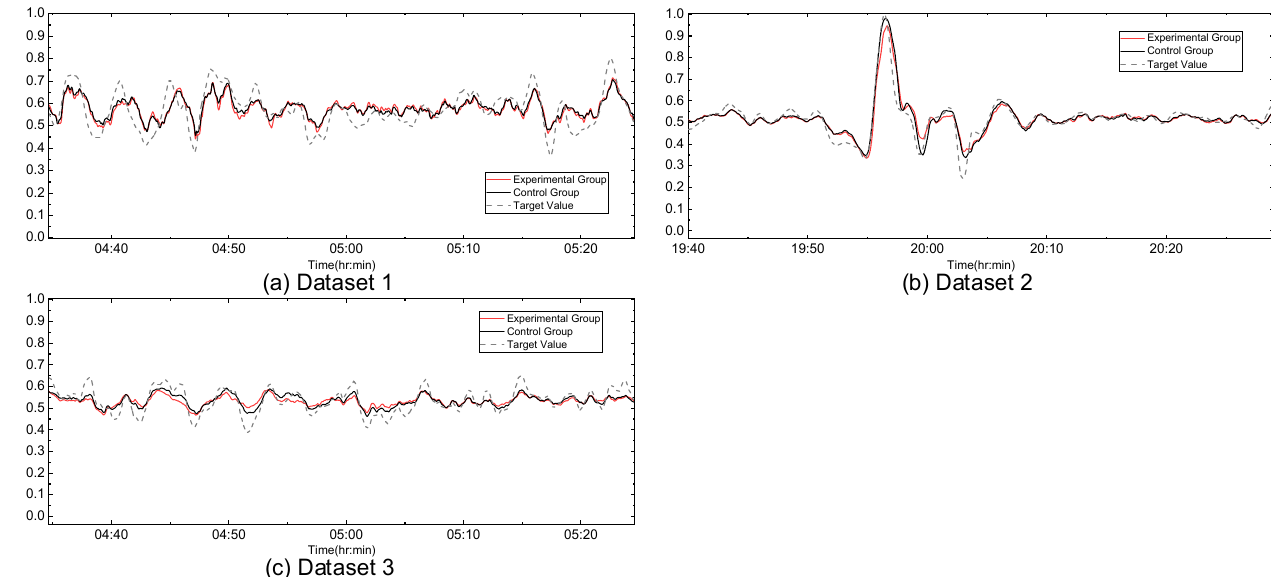
Figure 14. The prediction comparison diagram of segmented training. Table 9. The prediction comparison table of segmented